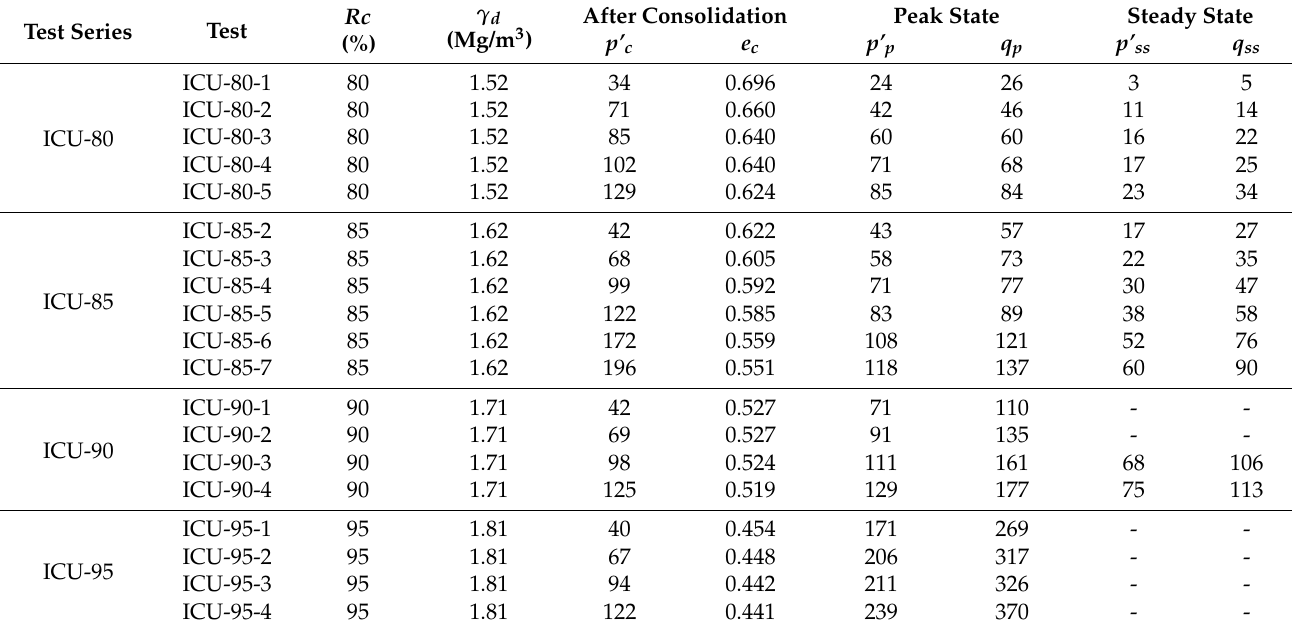
and a high-speed data acquisition system (Figure 2). The hanger with dead weight was used for the CS tests and the load frame was used to apply strain-controlled displacement for ICU tests. The data acquisition system consisted of three pressure transducers, an internal submersible load cell, a volume change measurement device, an axial displacement transducer, an amplifier, and a computer with an analog-to-digital card. Table 2. Isotropically consolidated undrained (ICU) test series.